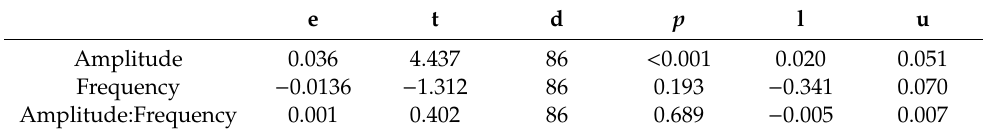
Figure 2. Perceptual sensitivity to video speed modulation as a function of video speed modulation amplitude (10%, 30%, and 50%) and frequency (1, 2, and 4 Hz), shown separately for Ripples and RDK videos. Error bars are 95% confidence intervals. Table 1. Results of the generalized linear mixed models (GLMM) analysis of perceptual sensitivity.